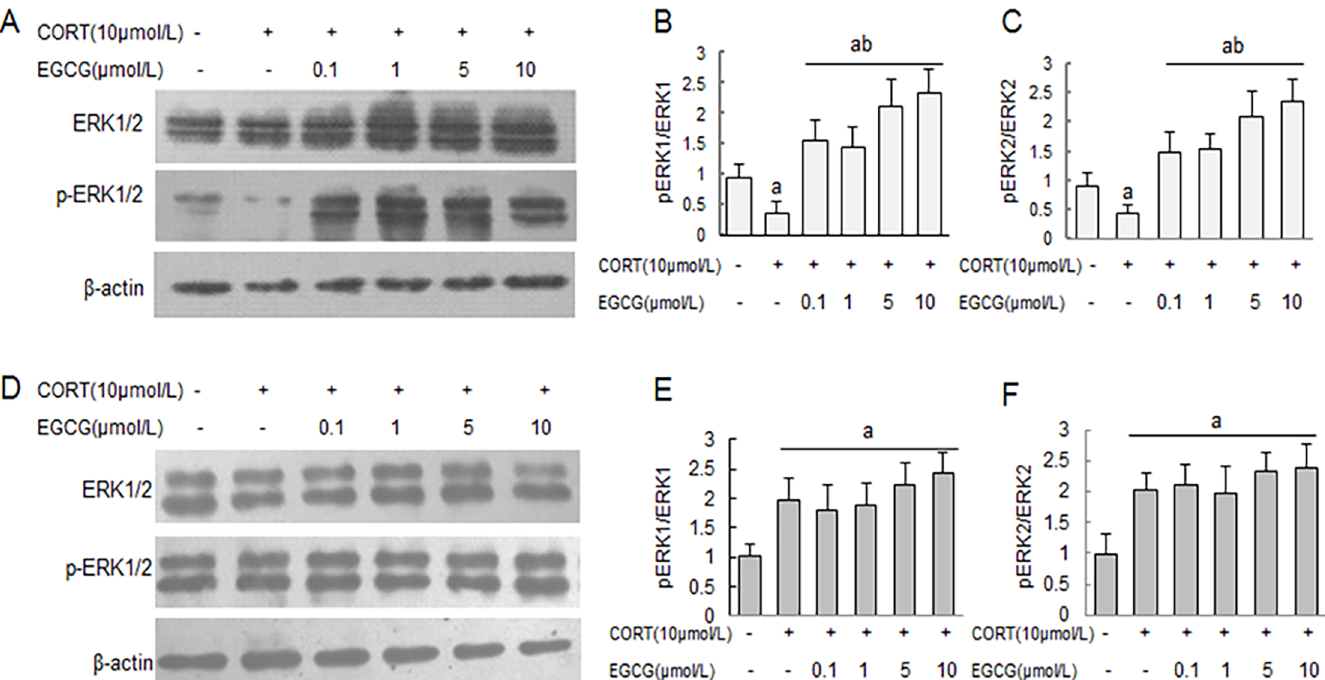
Fig 5. The effect of EGCG on CORT-induced alteration of ERK1/2 phosphorylation in primary hippocampal neuron cultures. Primary hippocampal neuron cultures were pre-treated with EGCG at indicated concentrations for 2 h before stimulating with CORT for 1 h (A) and 24 h (D), respectively. The cellular levels of total and phosphorylated ERK1/2 were determined by western blot analysis with reference to a house-keeping protein ( β -actin) as loading control. The relative protein levels were expressed as the relative band density of the corresponding protein (B, C, E and F). a P < 0.05 vs normal control group: b P < 0.05 vs CORT treatment group.